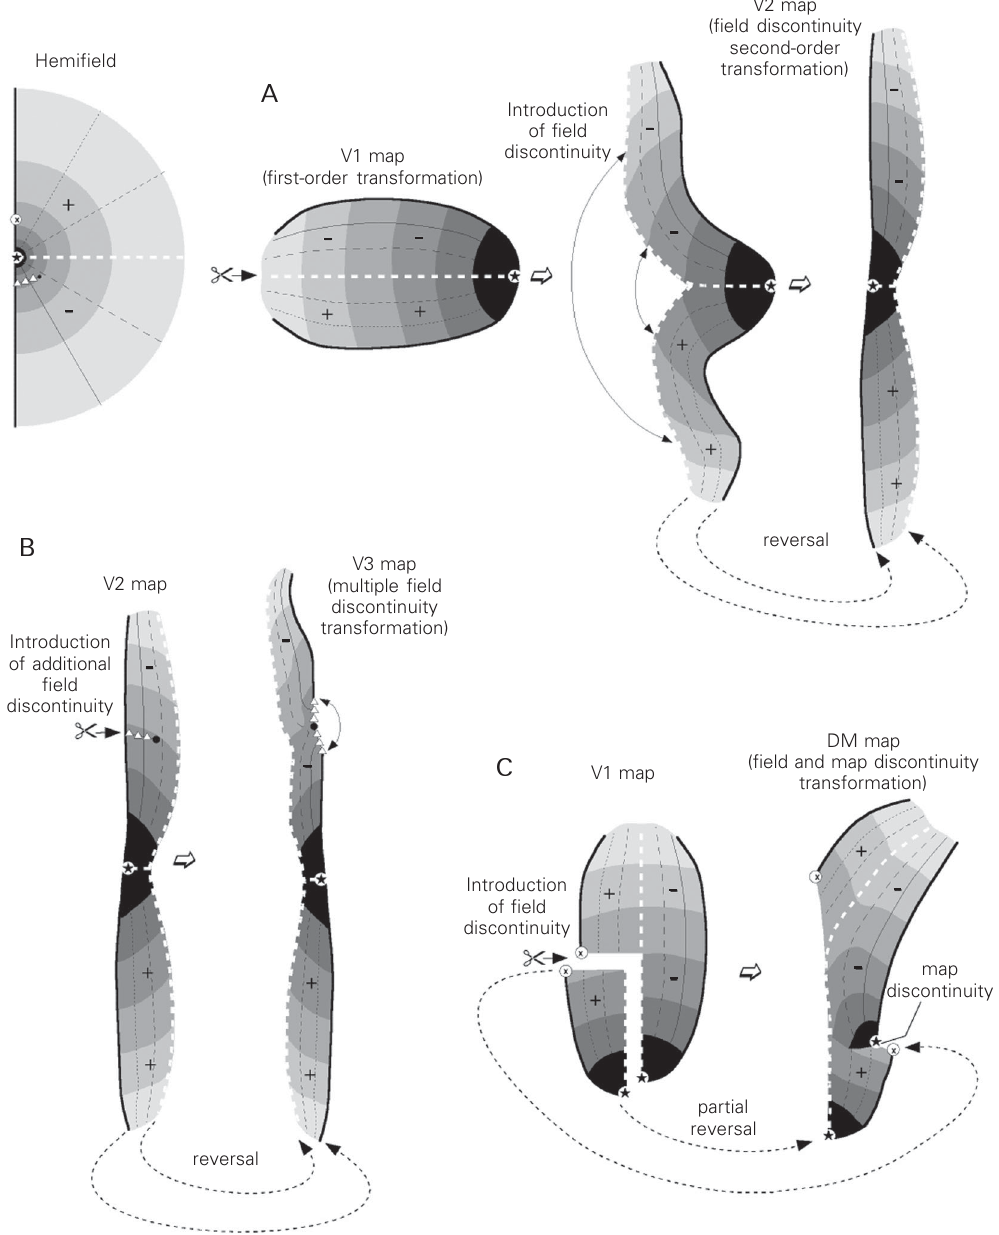
Figure 2. Different types of visuotopic map can be seen as topological transformations of the V1 map. Top left , Schematic representation of the visual hemifield, illustrating the coding of different visual field parts used in the maps shown in A-C. A , “Simple” field discontinuity maps, such as V2, can be imagined as a result of cutting and physically separating a first-order representation map. B , Visuotopic maps can include secondary field discontinui- ties, such as those observed along the rostral border of primate V3 (circle and triangles). C , More rarely, maps may include map discontinuities, regions where the receptive field coordinates change suddenly. For example, in the dorsomedial (DM) area of marmosets the central and peripheral parts of the upper contralateral hemifield are represented in spatially segregated sectors. This transformation can be imagined as the result of cutting off an entire “island” of cortex, and re-attaching it to the map with a different orientation. As a result, there is a small region along the rostral border of DM where cells with receptive fields in the mid-peripheral region of the upper quadrant adjoin cells with receptive fields in the central lower quadrant (map discontinuity). Note, however, that this transformation preserves the continuity and the centroperipheral axis of the horizontal meridian representation (white dashed line), resulting in a congruent border between DM and V2 (see also Figure